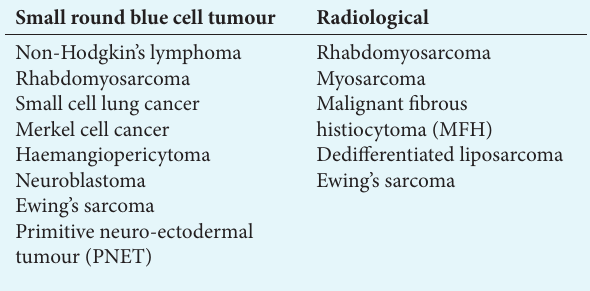
Table 1. Pathological and radiological differential diagnosis Small round blue cell tumour